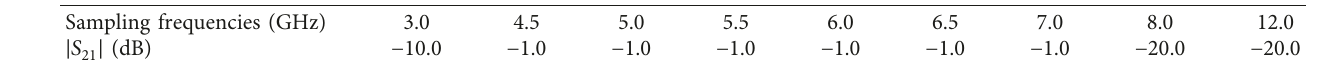
Figure 6: The configuration and equivalent circuit of the double-layer band-pass FSS with steep falling-edge stopband. (a) Geometry of one element of the FSS. (b) Equivalent Table 1: Samples from the desired frequency response of S 21 .